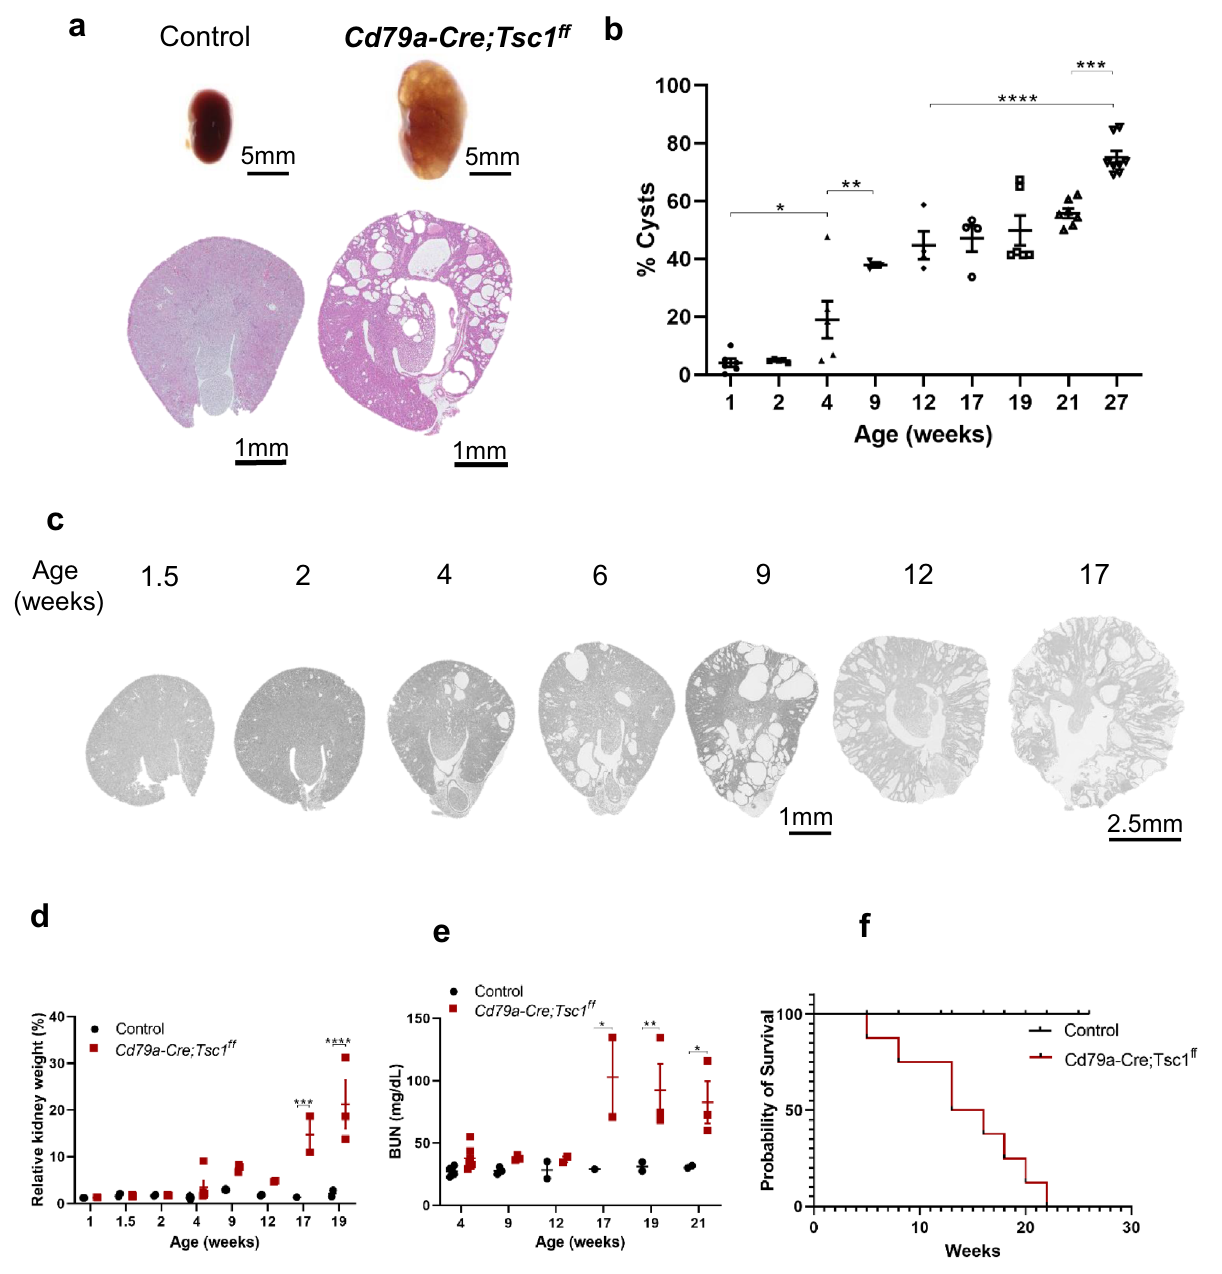
Figure 1. Cyst progression in Cd79a-Tsc1 knockout (KO) mouse kidneys. ( a ) Gross appearance of a cystic kidney. Sections at 4 weeks of age by hematoxylin and eosin stain. ( b , c ) Time-course progression of renal cysts. A series of representative images from the age of 1.5 to 17 weeks and the corresponding cystic indices are shown. The cyst index is given by a fraction of cystic lesions in whole kidney area. ( d ) Progressive enlargement of Cd79a-Tsc1 KO kidneys. A dramatic increase in kidney weight is observed after 4 weeks. The ratio of total kidney weight to body weight is indicated as a percentage. ( e ) Changes in renal function. Blood urea nitrogen (BUN, mg/dL) levels steeply rose after 12 weeks in Cd79a-Tsc1 KO mice compared with controls. ( f ) Kaplan– Meier analysis shows reduced viability of C79a-Tsc1 KO mice after 20 weeks of age. Control n = 15, male n = 8, female n = 7. Values represent mean ± SEM, and statistical significance was determined by two-way ANOVA. * P < 0.05, ** P < 0.01, *** P < 0.001 and **** P <